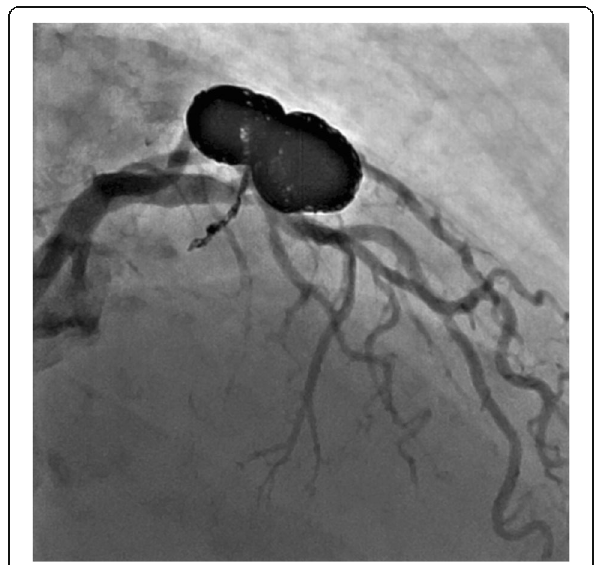
Fig. 5 Post-interventional angiogram. The additional aneurysm sac was coiled via the dominant feeder arising from the LAD. Complete obliteration was